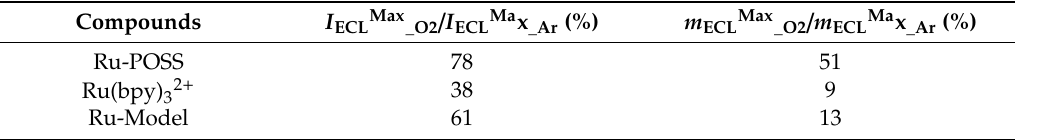
Table 2. Residual rates of maximum ECL intensities and onset increase rates in BE in the aerated solutions compared to the hypoxic